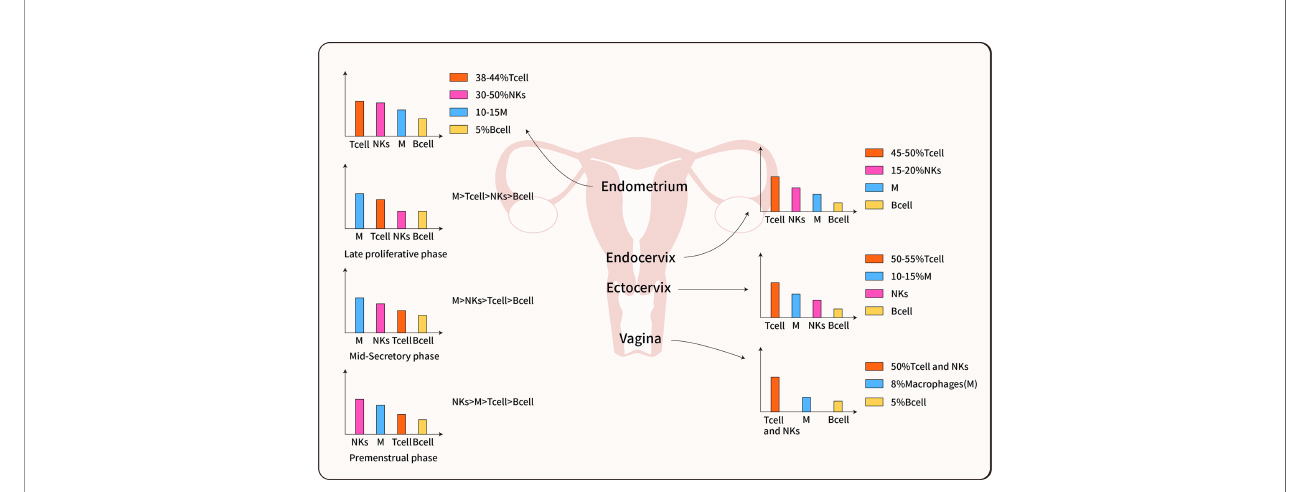
FIGURE 2 | Immune cell distribution in the female reproductive tract. The predominant immune cells are T cells, Macrophages, NK cells, and B cells. The immune cells inconsistent distributed in each organ of the female reproductive tract, furthermore, most data indicate the immune cells also differentially populations in all phases of the menstrual cycle (14, 21,